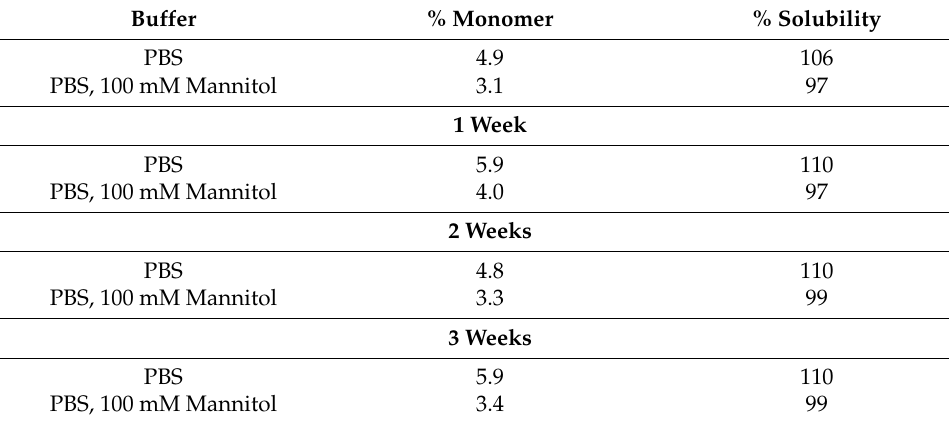
Table 2. Stability of EPT powder in chosen buffer excipients.